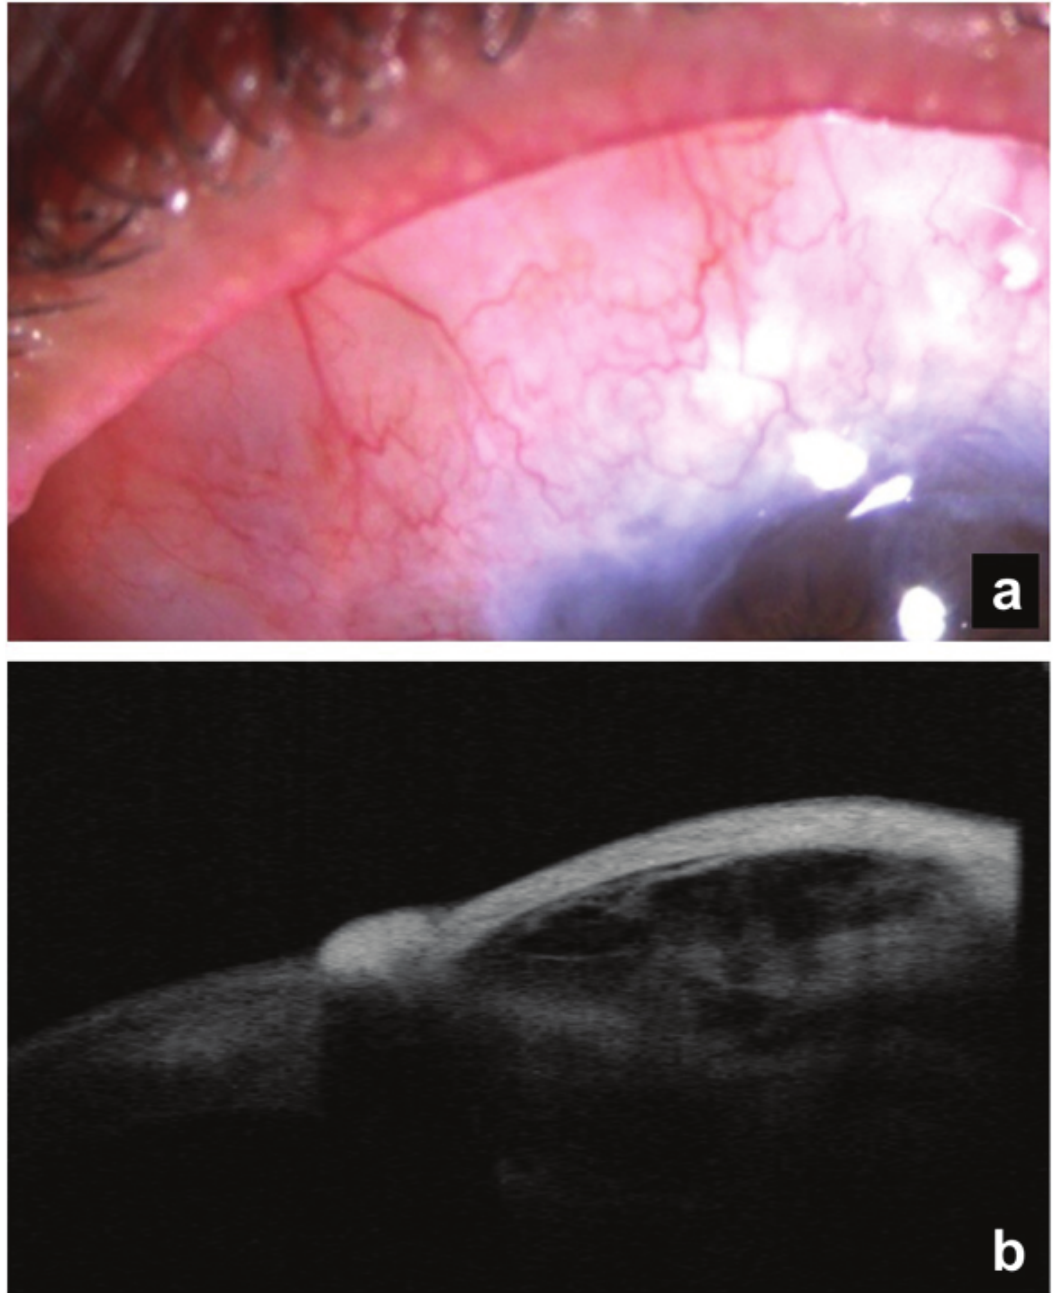
Figure 3. (a) Postoperative clinical photograph showing a moderately elevated and vascular, diffuse functional bleb after three months. (b) Postoperative ASOCT image showing decrease in the bleb height, a thicker epithelium, and less hyporeflective spaces within the bleb